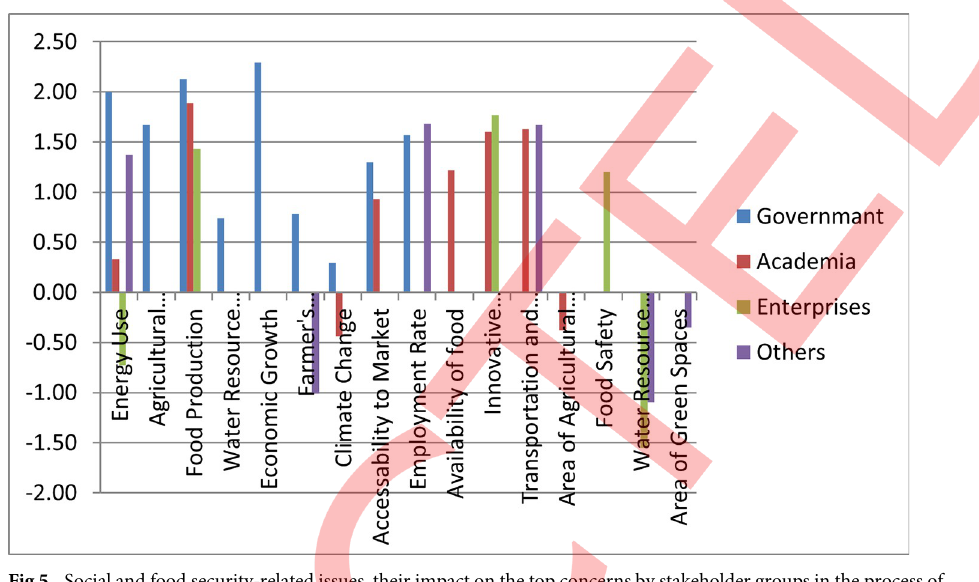
Fig 5. Social and food security-related issues, their impact on the top concerns by stakeholder groups in the process of CPEC initiatives’ (a. Government; b. Academia; c. Enterprise; d. Others). Source: Based on the author’s calculation, weighted to issues according to data collected by